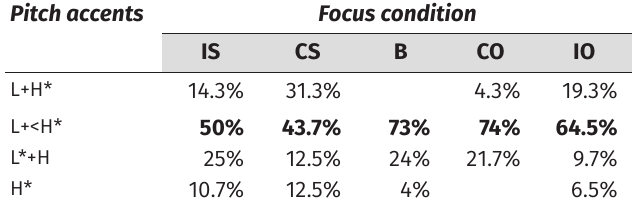
Table 3: Pitch accents produced on subjects in five different focus conditions: informational subject focus (IS), contrastive subject focus (CS), broad focus (B), contrastive object focus (CO) and informational object focus